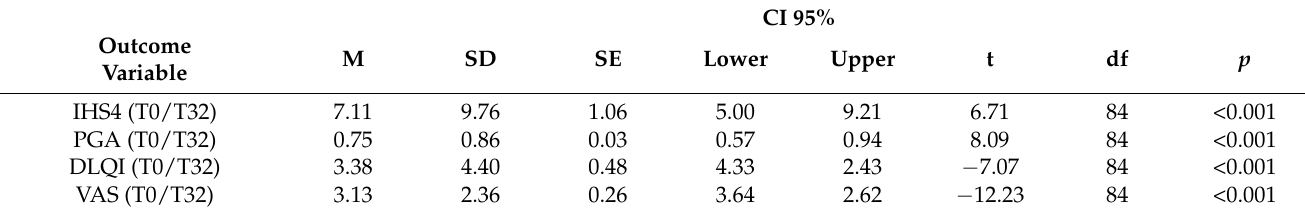
Table 2. Mean improvement from baseline to follow-up (T0-T32) for clinical and patient-reported outcome measures.